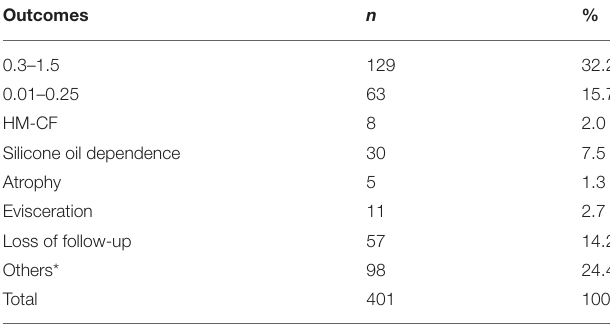
TABLE 4 | Final outcomes of 401 eyes of pediatric